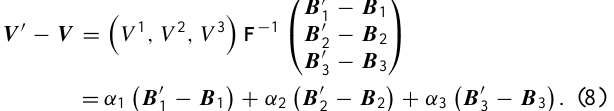
Fig. 1. Calibration triplet B 1 , B 2 , B 3 and the geographical North-East-Down frame { u i } . The unit vectors e 1 , e 2 , e 3 (defining the physical axes) are nearly orthogonal, and each e i is close to corresponding u i . The large gray ball represents the variation of vector V (the one to be measured after calibration); small balls radii represent the measurement error εb ; value δb is the upper bound for all | B i − B k | , i , k =1, 2, 3 ; b is a typical value of the intensity of the geomagnetic field at the site and epoch of measurements.